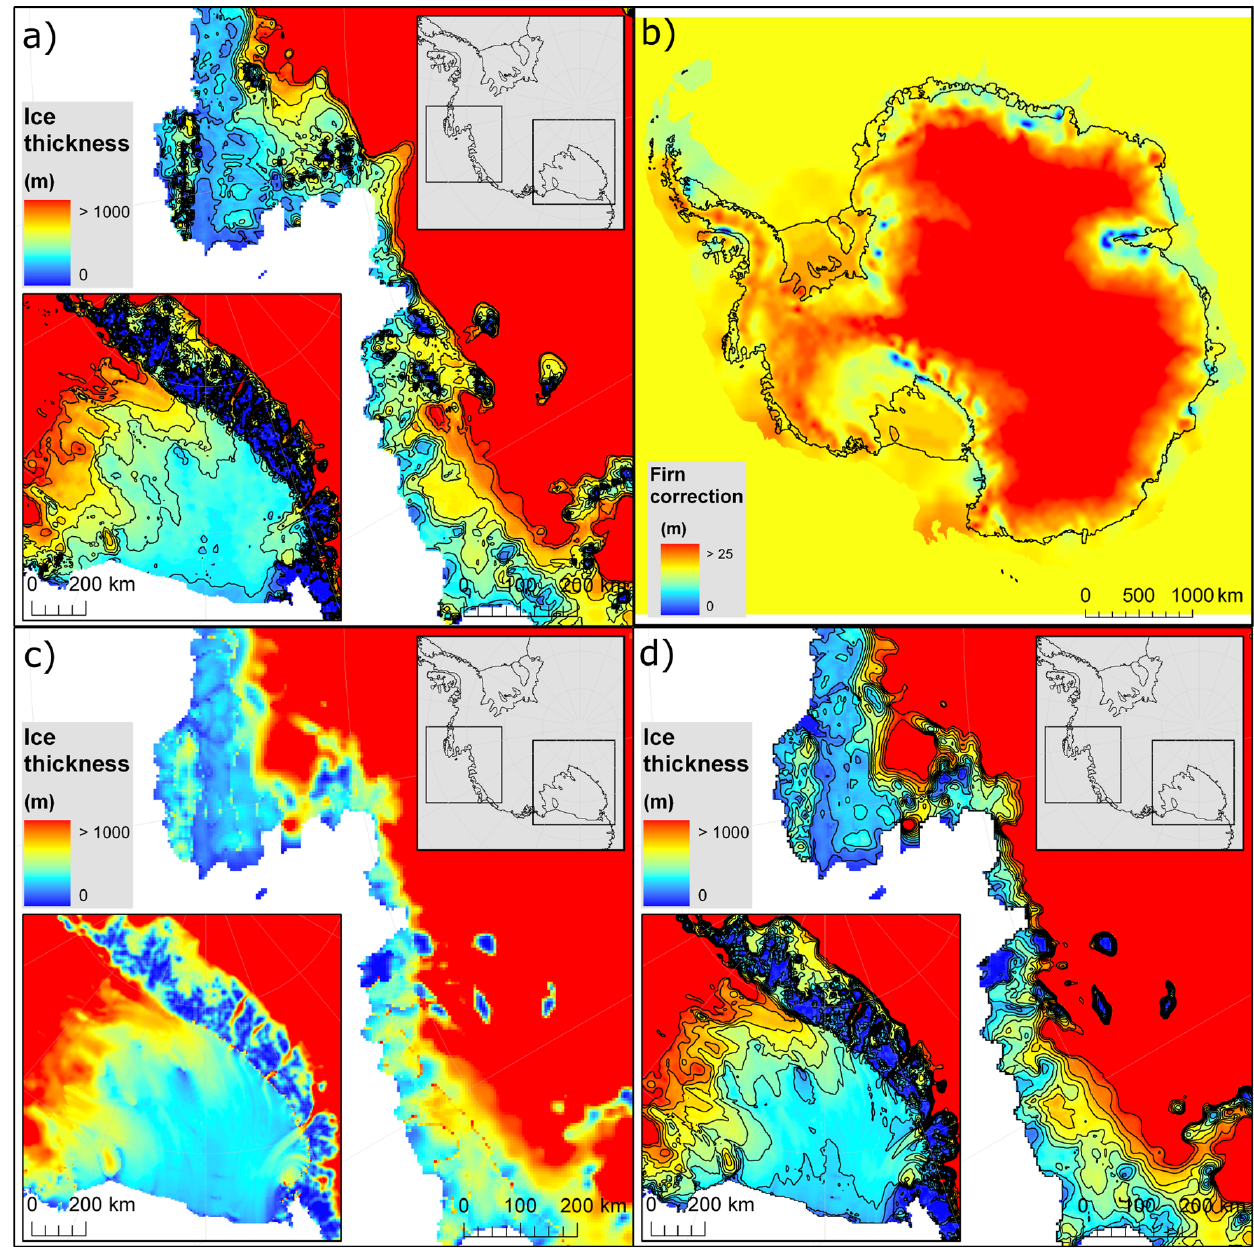
Figure 3. Ice thickness join: (a) original BEDMAP ice thickness, (b) firn correction used in calculating the floating ice thickness, (c) unsmoothed combined grounded and floating ice thickness and (d) smoothed combined grounded and floating ice thickness. Contours show 100m thickness intervals (up to 1000m), they are not shown on (c) for clarity in showing the join between floating and grounded ice thickness datasets.